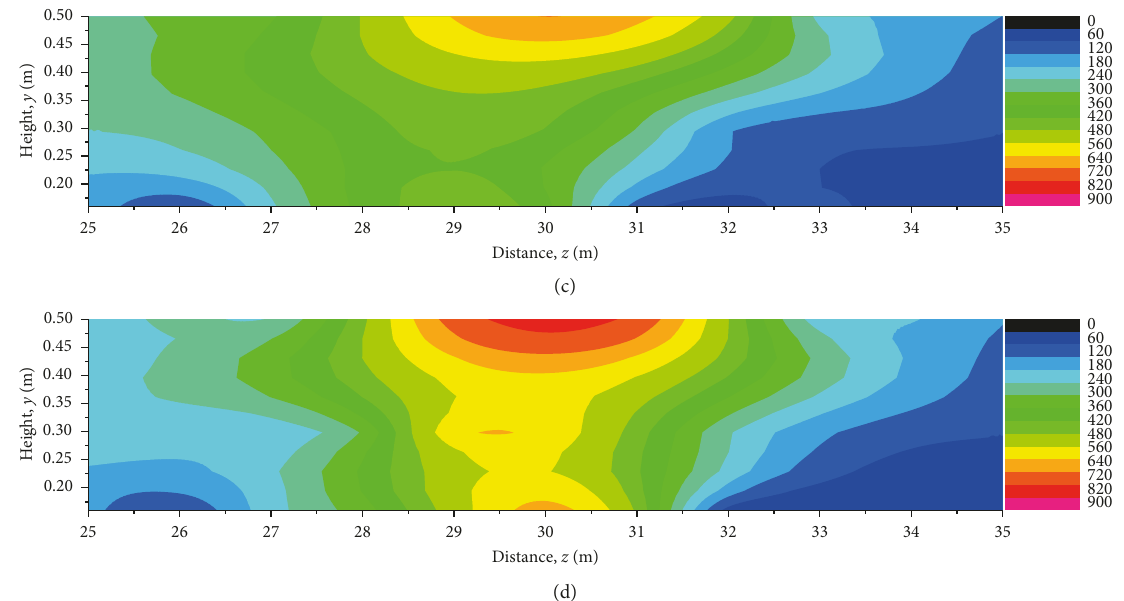
Figure 10: Cloud pictures of temperature distribution. (a) V 1